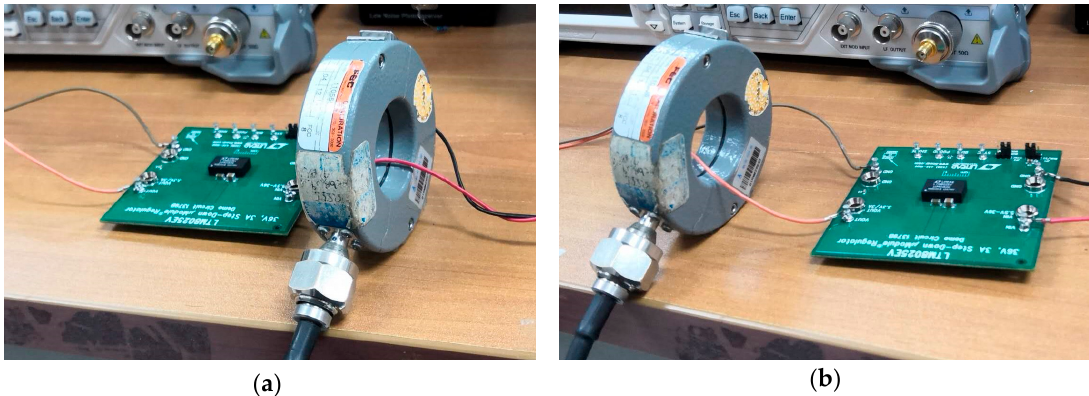
Figure 1. Board diagram and schematic of DC1379B [29]. ( a ) Printed circuit board (PCB) and its layouts; ( b ) Schematic.